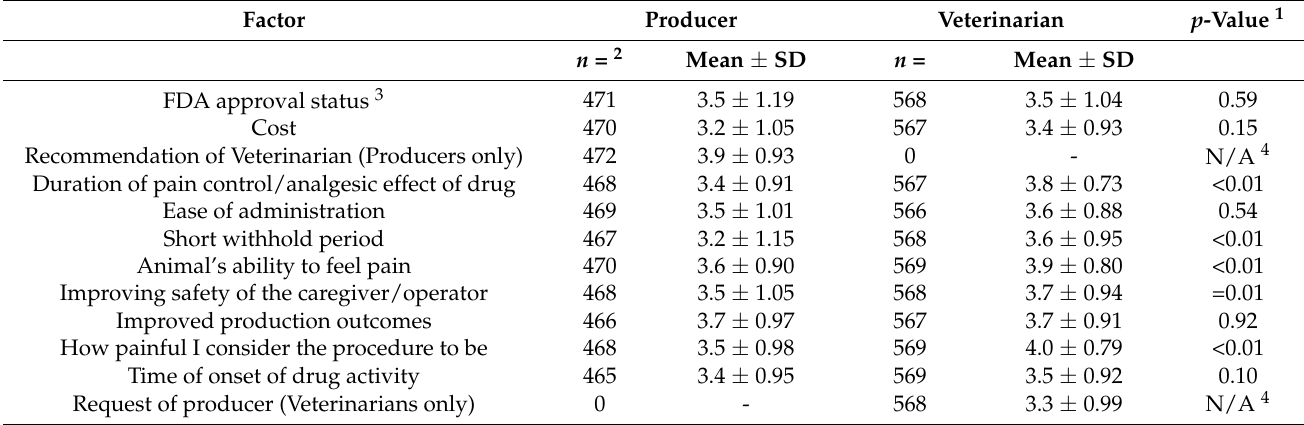
Table 6. Summary (mean ± standard deviation) and Mann-Whitney test results ( p -value) for Likert scale-based factors ranked by producers and veterinarians for each of the items below corresponding to their importance in impacting the decision to use an analgesic drug in adult cattle and calves (1: minimum/not at all important − 5: maximum/extremely